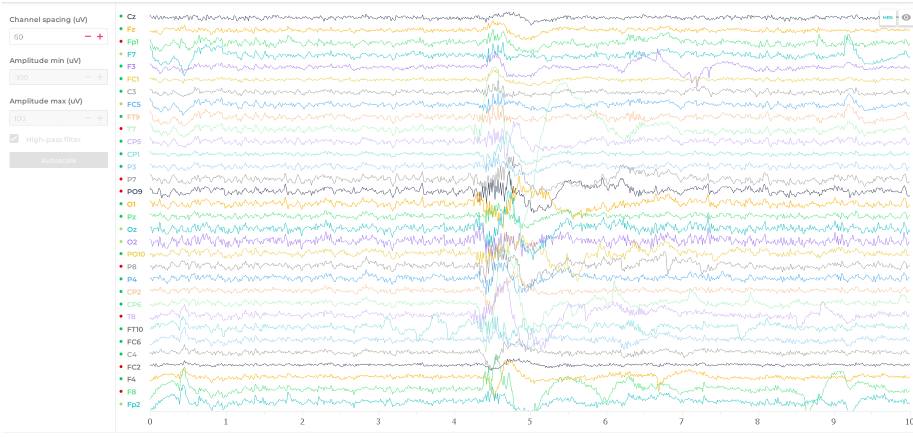
Figure 11. An example of a nervous tic involving the lifting of the right shoulder (shoulder muscle tightening).